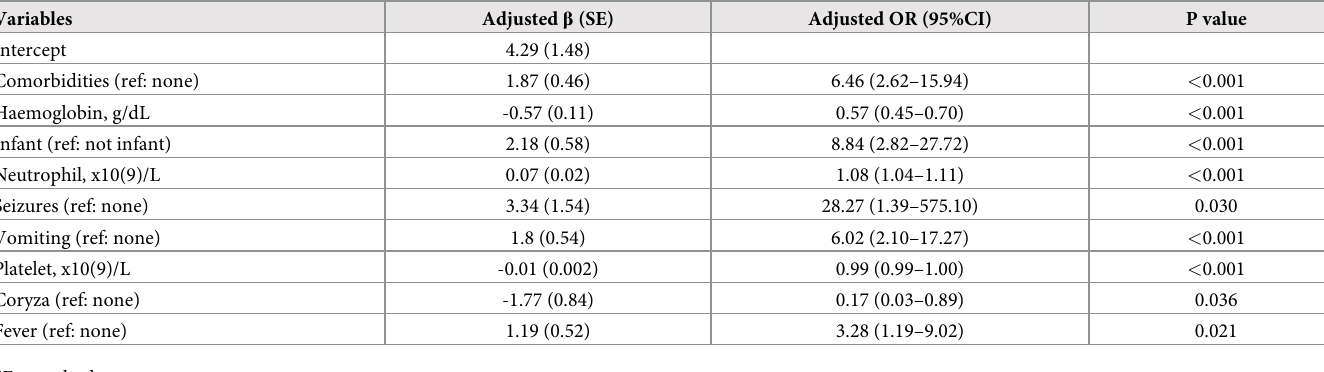
Table 3. Final multivariable model predicting severe/ critical COVID-19.